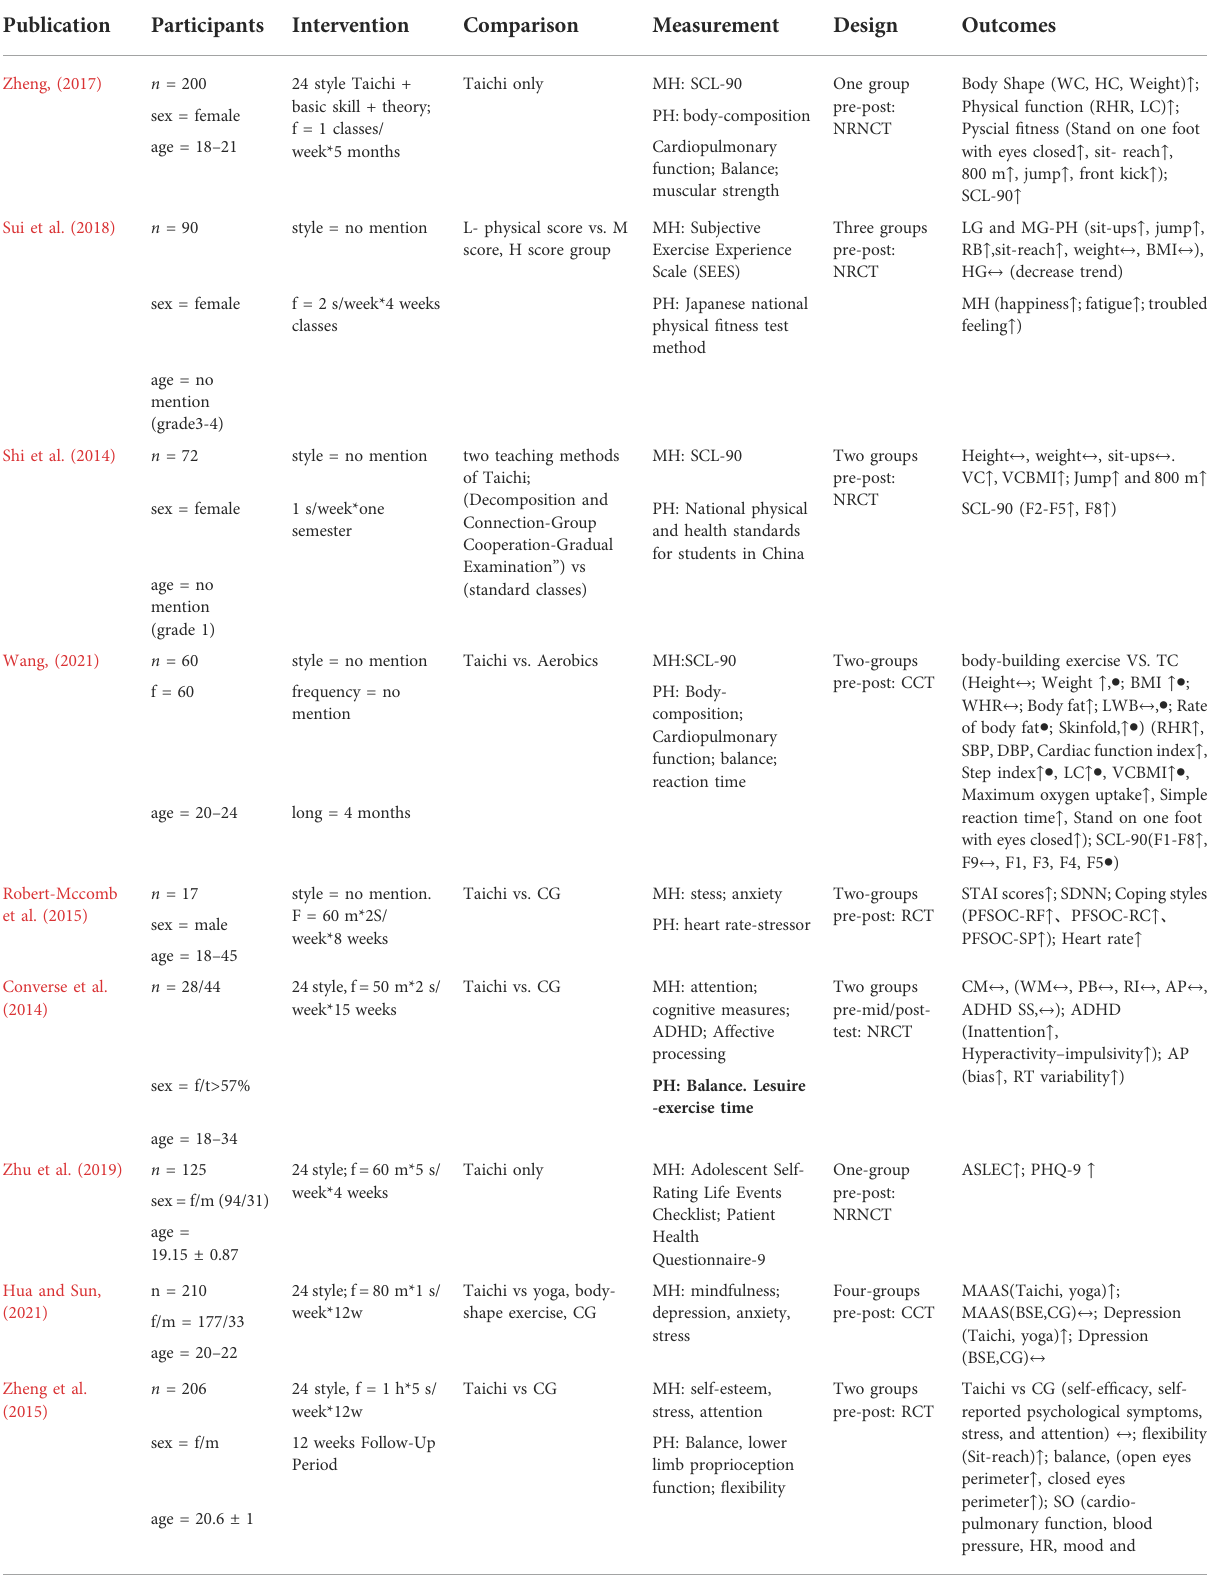
TABLE 2 Overview of included